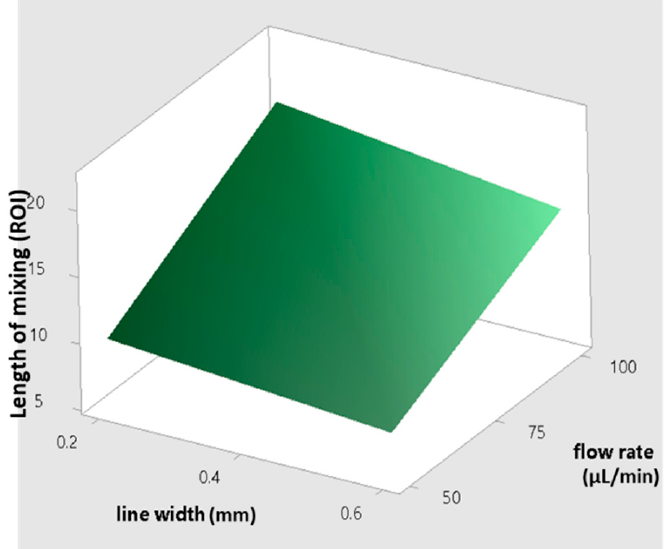
Figure 8. Surface plot for predicting the length of mixing versus different line width and flow rates.